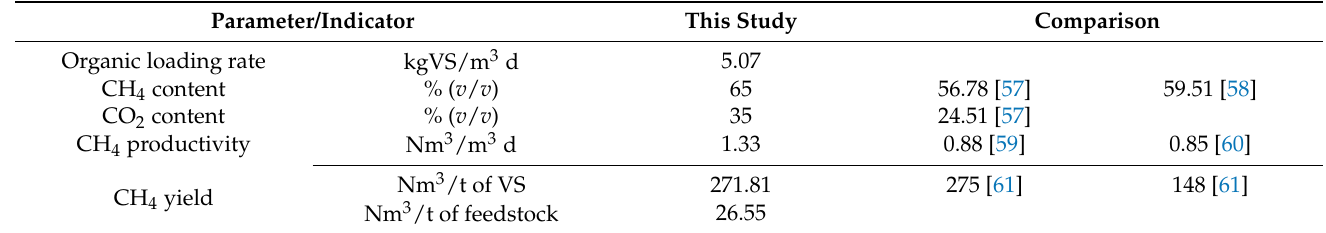
Table 2. AD results